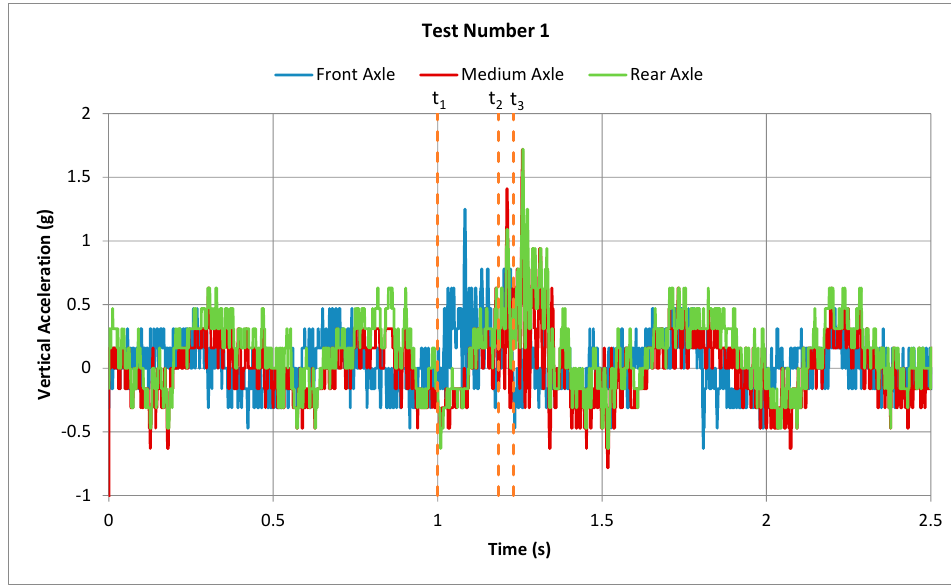
Figure 16. An example of accelerometer signals (front, medium and rear axles: Test Number 1) and axles’ bumps transiting over the bridge expansion joint.